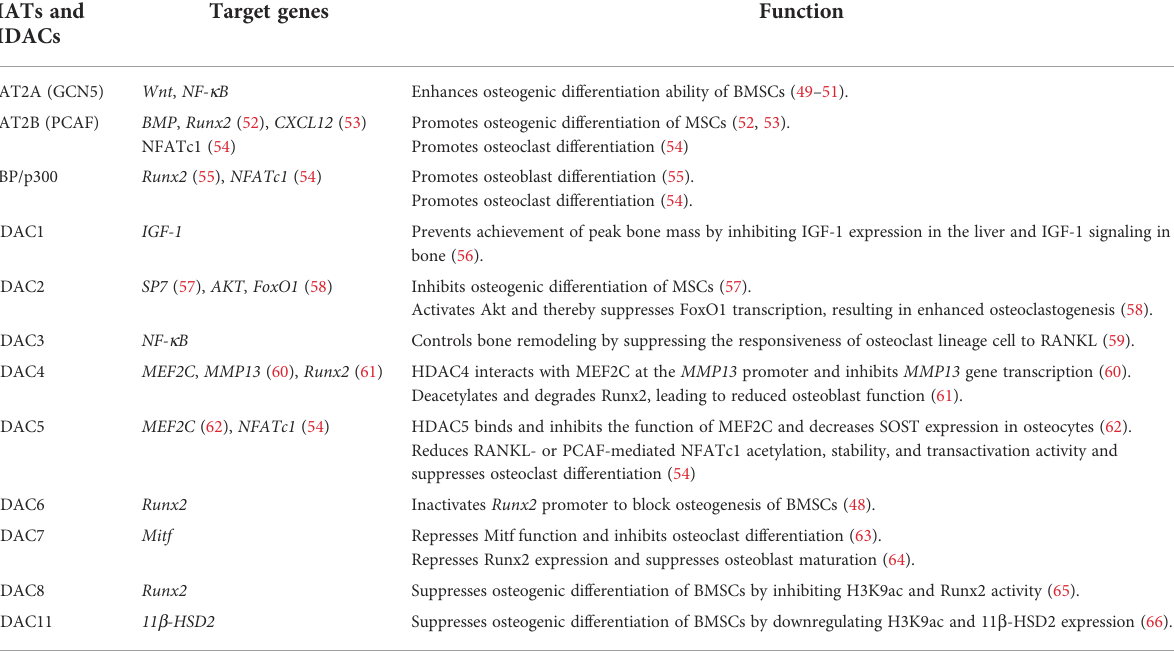
TABLE 2 Histone acetyltransferases, histone deacetylases, and their roles in the occurrence and development of osteoporosis. HATs and